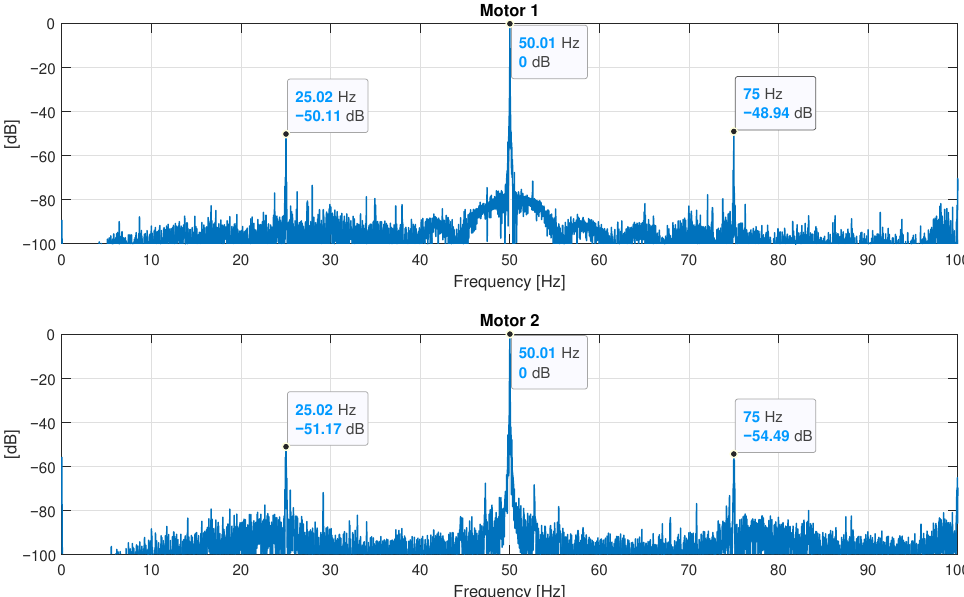
Figure 22. Spectra of the currents of the two tested motors, both of them of the type described in Appendix A. These spectra show the fault harmonics of an incipient-mixed eccentricity fault (marked in the figure), with a low level (around − 50 dB), which may be produced by inherent and unavoidable manufacturing